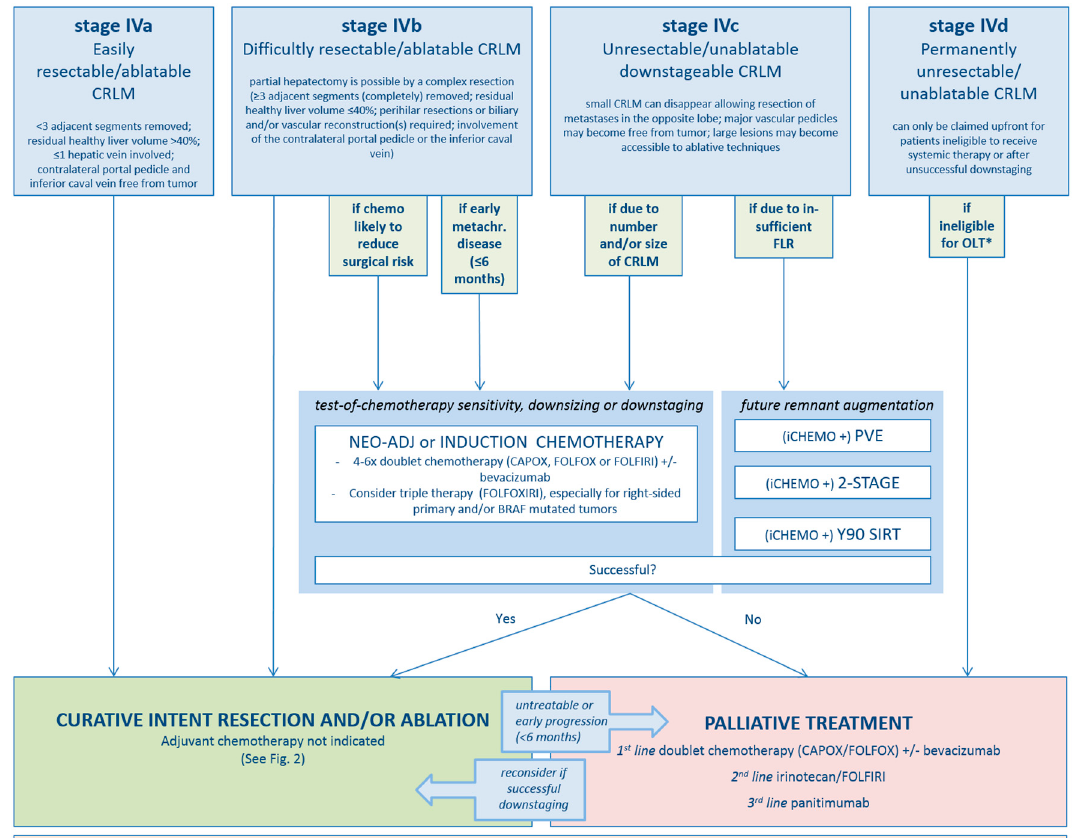
Figure 1. Per-patient flowchart.